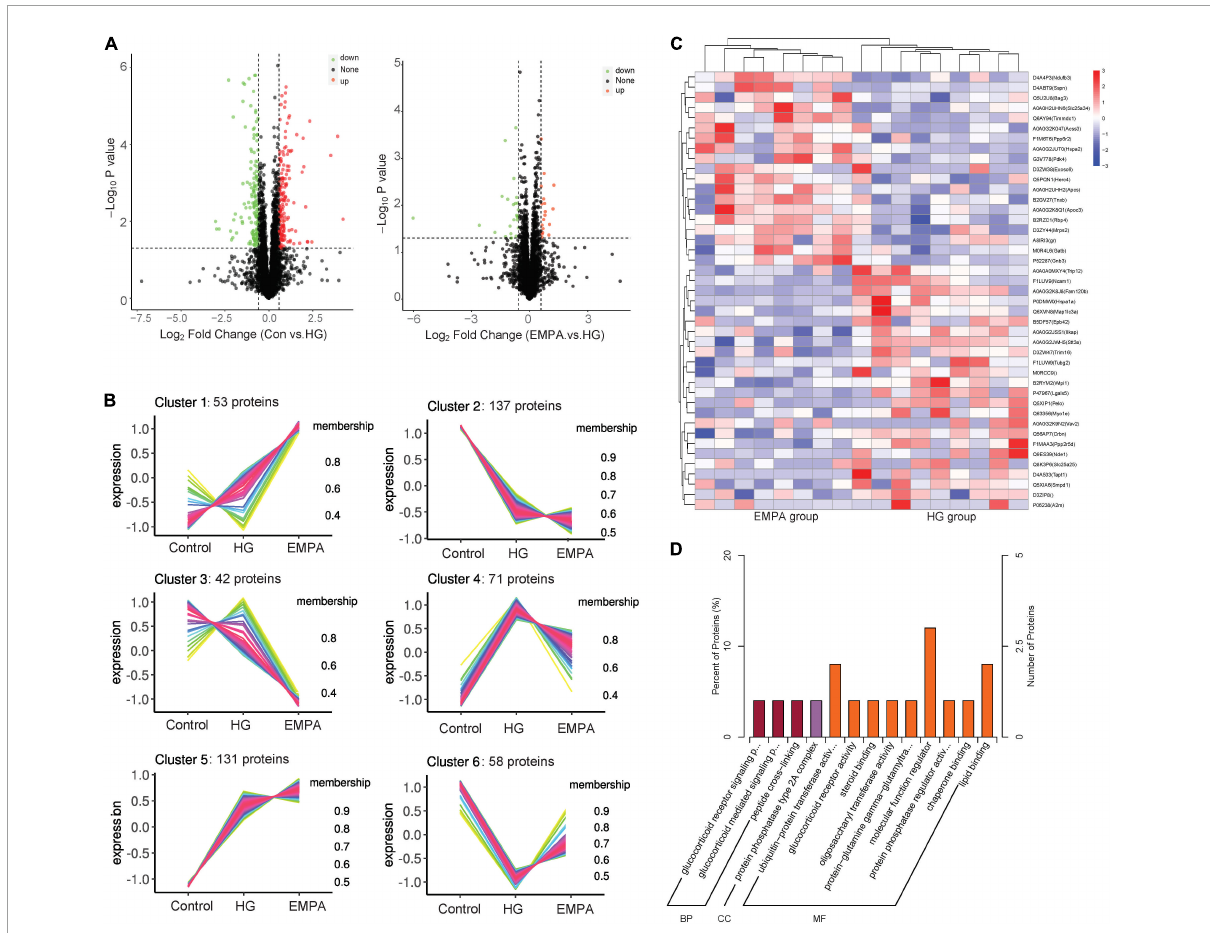
FIGURE3 The protein expression changes in the myocardium. (A) Volcano plots of protein expression changes. Cut-off value: p < 0.05, fold change (FC) ≥ 1.5 (upregulation) or ≤ 0.67 (downregulation), the red and green point represents the upregulated and downregulated proteins, respectively. (B) C-means cluster diagram of differential proteins. The proteins are classified into 6 clusters according to their expression levels in each group, and the horizontal coordinate is the group, the vertical coordinate is the protein expression level (correction Z -value), each line represents one protein, larger membership values indicate that the protein is closer to the average level protein of this cluster. (C) Hierarchical clustering analysis of differential in empagliflozin (EMPA) and high glucose (HG) group. (D) GO enrichment of differential proteins in EMPA and HG groups. BP, biological process; CC, cellular component; and MF, molecular function.